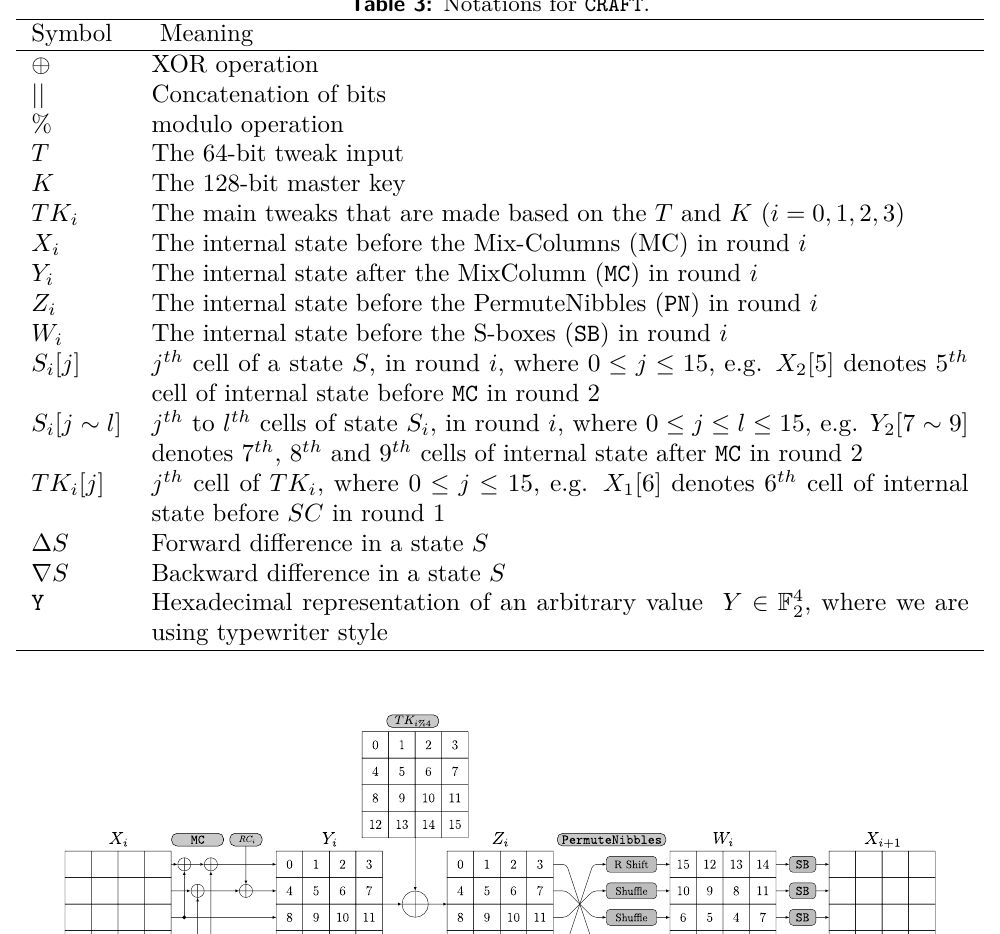
Table 3: Notations for CRAFT .